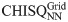
The mean absolute error of the estimates of four central parameters of the LCA (common input v, leakage γ, mutual inhibition κ, evidence threshold a) as a function of sample size (abscissa) and for three different methods: (1) choosing the nearest neighbor grid point in the space of summary statistics (CHISQNNGrid, triangles); (2) using the average of a set of nearest neighbor grid points based on bootstrap samples (CHISQBSGrid, open circles) and (3) using SVM interpolation between the 100 nearest neighbors (CHISQBSSVM, crosses).